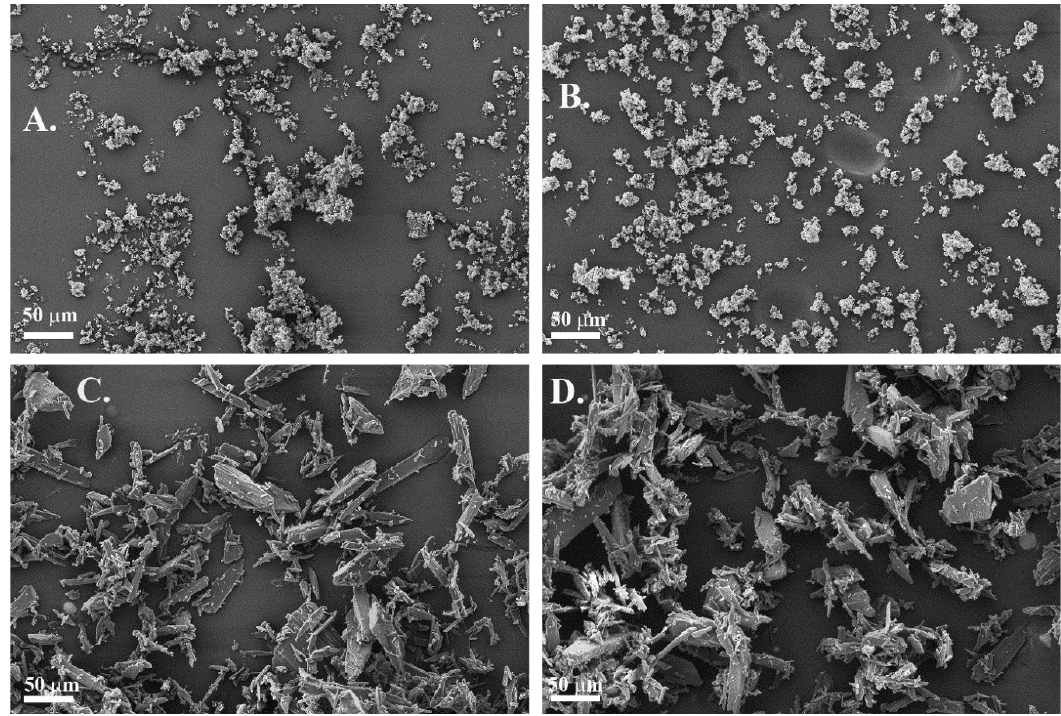
Figure 1. SEM images of spironolactone ( A , B ) and paracetamol ( C , D ). Unprocessed raw materials